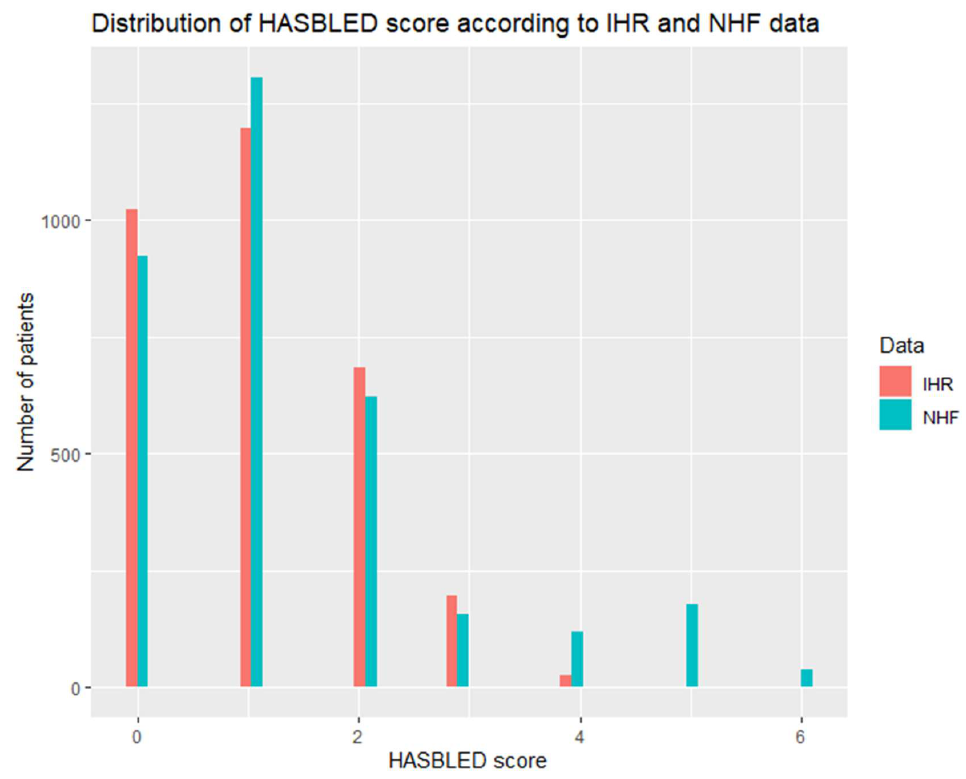
Figure 2. Distribution of HASBLED score within the cohort according to IHR and NHF data.